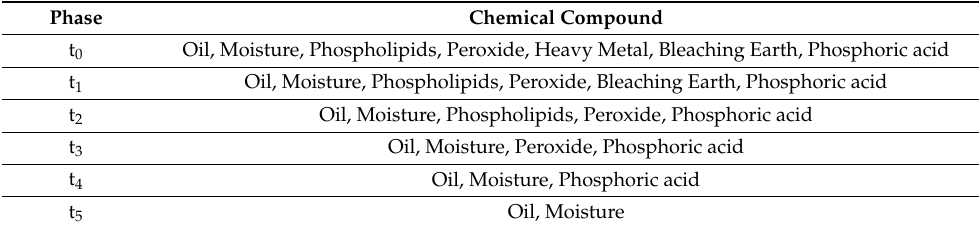
Table 7. Summary of remaining chemical compounds.